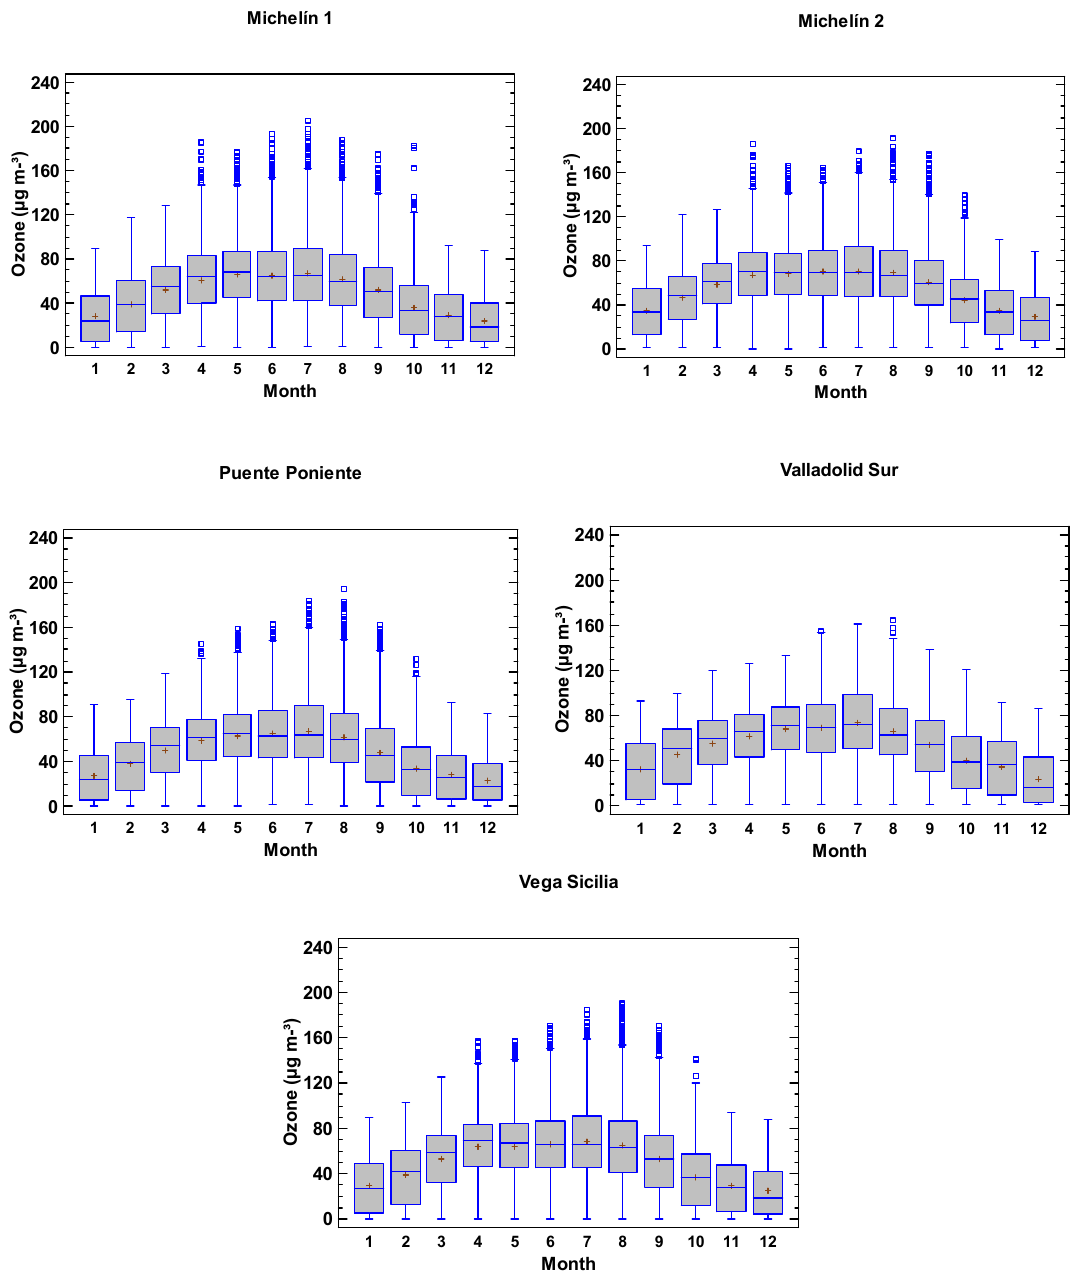
Figure 4. Monthly evolution of ozone concentrations at each measuring station in the study period.